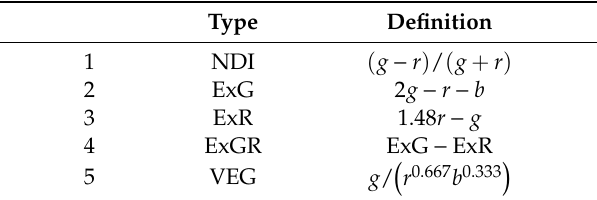
Table 1. Common vegetation